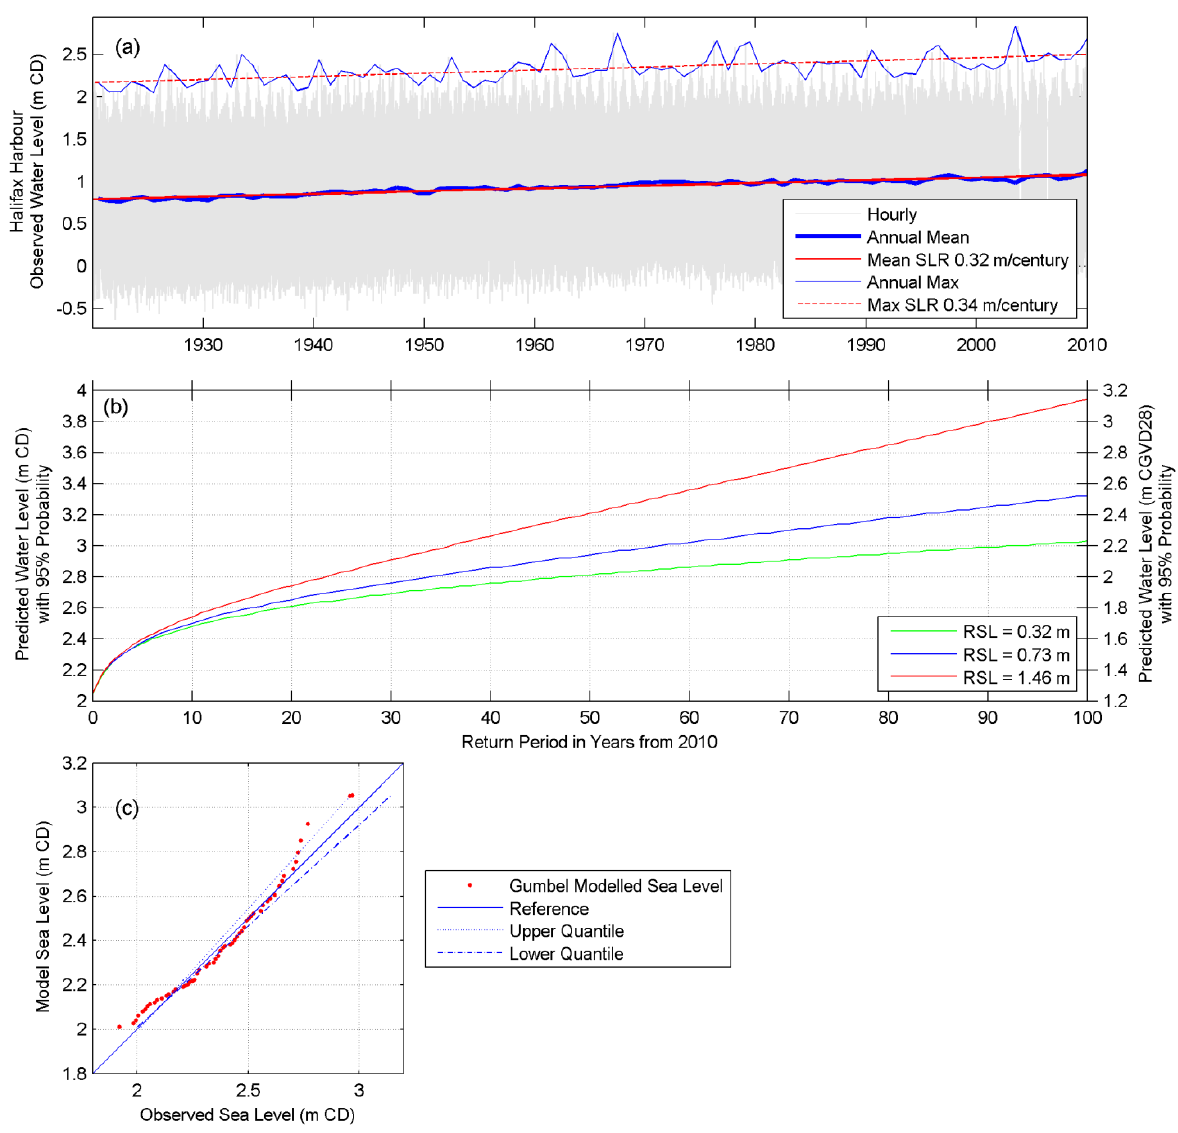
Figure 6. ( a ) Halifax hourly, annual mean and annual maximum water levels above chart datum for 1920 to 2010, mean sea level rise (0.32 m/century) and maximum sea-level rise (0.34 m/century); ( b ) Design Level graph for Halifax. Expected water levels to be reached over time with different rates of relative sea-level (RSL) rise (m/century), green: current rate 0.32 m/century, blue: 0.73 m/century [33], red: 1.46 m/century [35]. Left vertical axis in CD, right vertical axis in CGVD28; ( c ) the Gumbel distribution used to model annual maximum sea level at Halifax.